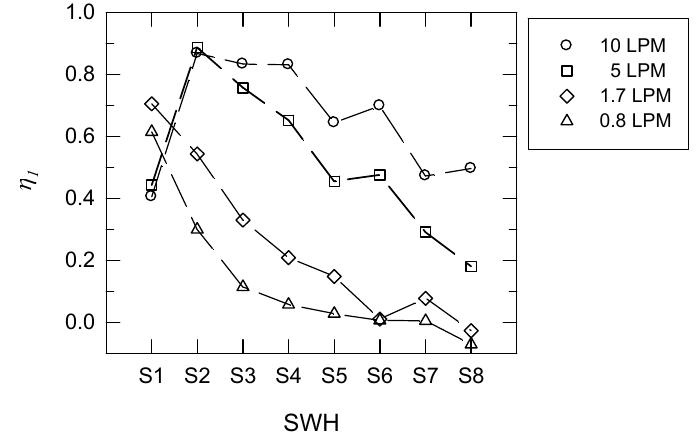
Figure 10. Output energy of SWHs, continuous load